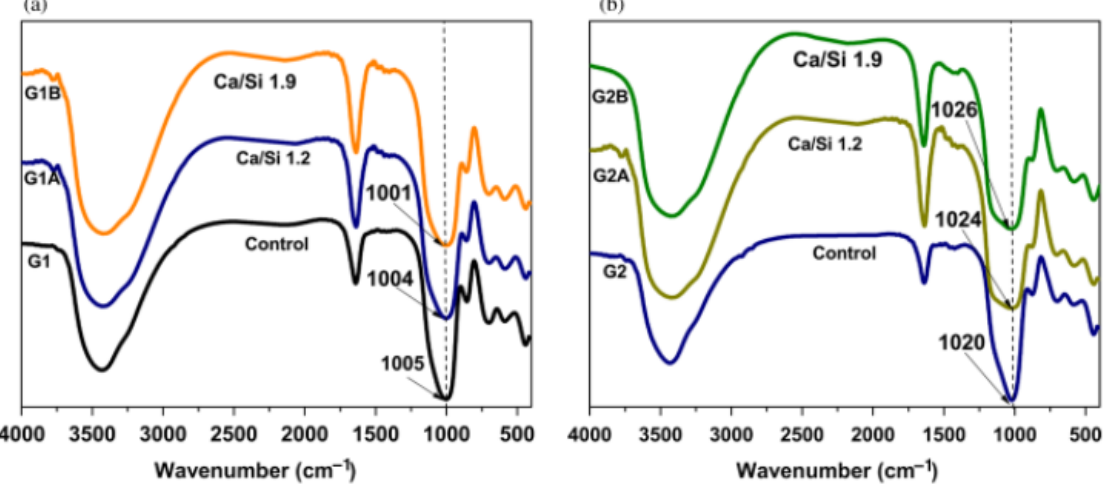
Figure 4. Aluminosilicate (Si-O-T) band due to an increment in C/S ratios ( a ) Si/Al = 1 and ( b ) Si/Al = 2 (From Wiley Ref. [74] with copyright permission). = 2 (From Wiley Ref. [74] with copyright